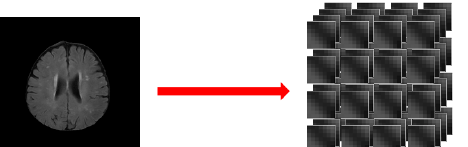
Figure 4. Brain MRI segmentation based on patch convolutional neural network (CNN) method, splitting the image into patches of size 7 × 7 pixels.